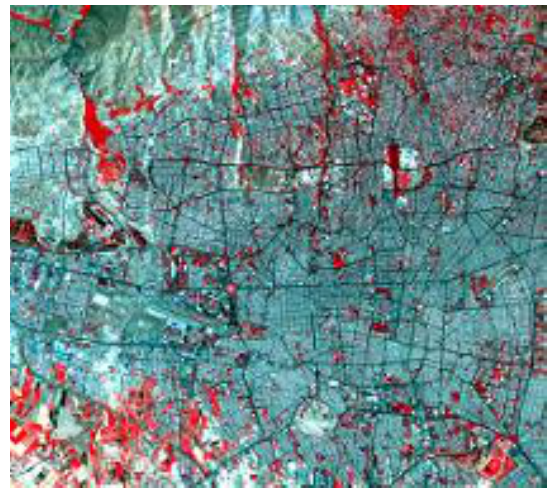
Figure 1. The false colour composition (4R3G2B) image of Landsat 5 TM (mountainous area in the northwest of image was masked)